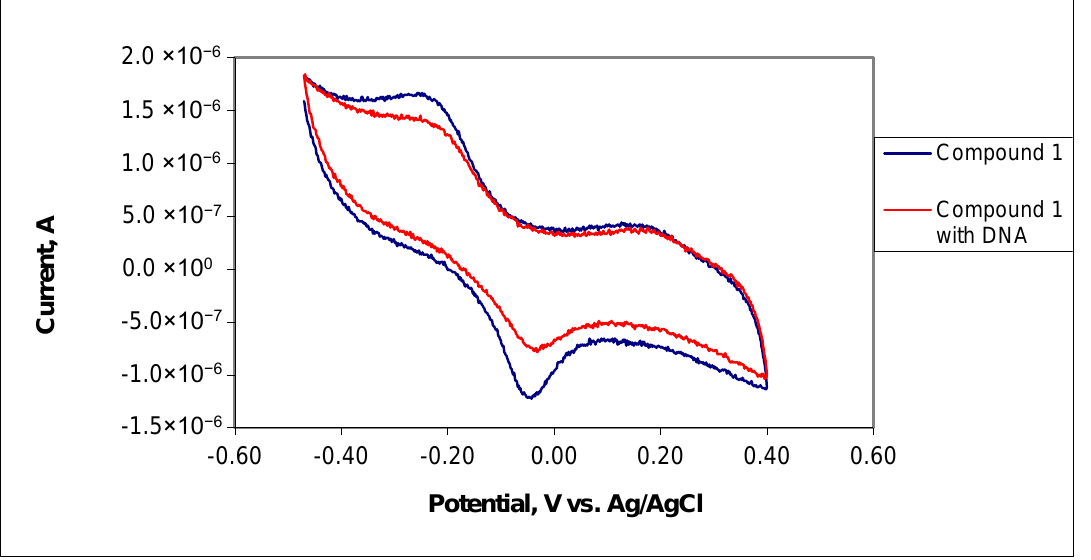
Figure 7. Cyclic voltammetry of Compound 1 before and after DNA addition in phosphate buffer solution at pH 7.4, scan rate 0.05 V/s.